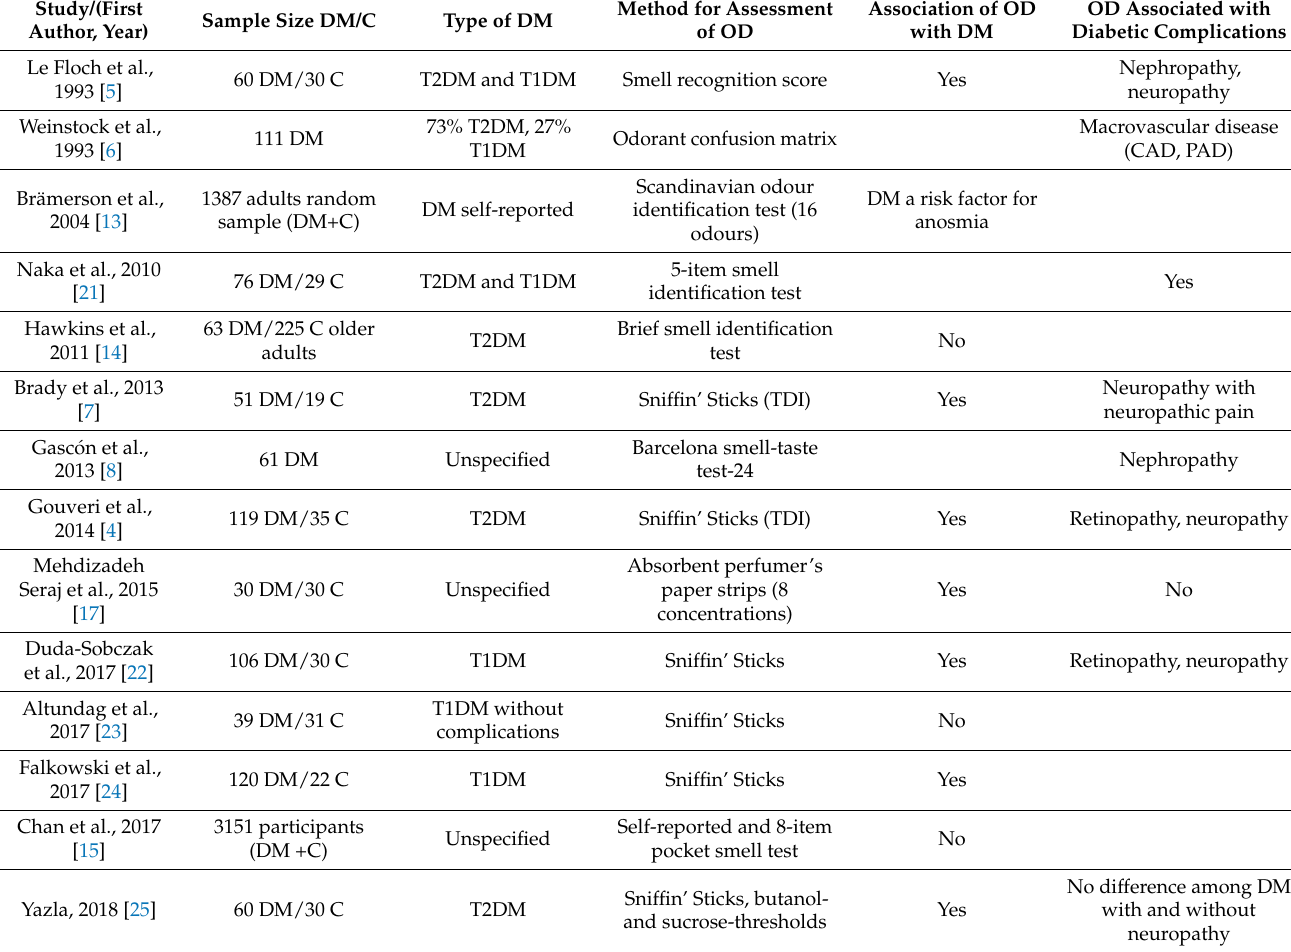
Table 1. Studies addressed the association of olfactory dysfunction with diabetes and diabetic